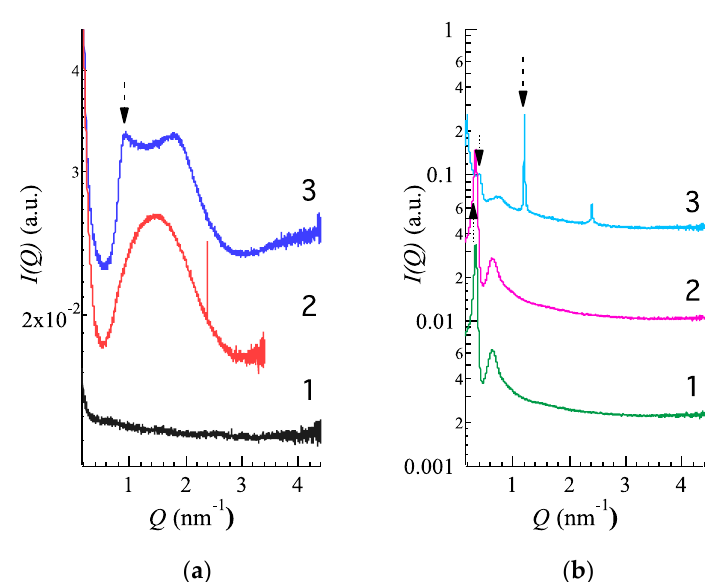
Figure 3. SAXS profiles observed at 35 °C. ( a ): water (1, black), ETHO (2, red), CA-ETHO (3, blue); ( b ): pol (1, green), CA-pol (2, violet), CA-ETHO-pol (3, light blue). Arrows indicate the main diffraction peaks.